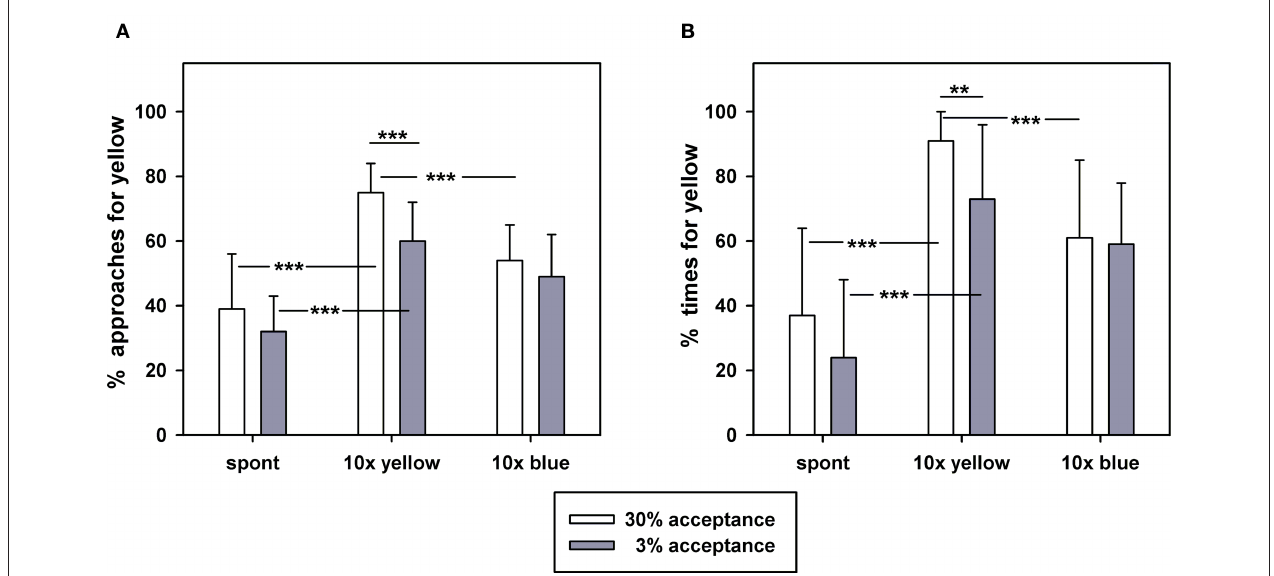
FiguRE 4 | Color learning at the hive entrance for two groups of bees which had acceptance thresholds ≤ 3% or ≥ 30% in the field. The abscissa of both graphs show choice behavior before learning (spont), after 10 learning trials with a yellow plate marking the hive entrance (10 × yellow), and after 10 reversal learning trials with a blue plate marking the hive entrance (10 × blue). (A) The ordinate shows mean percentages of approaches and the respective standard deviations toward the yellow plate compared with the approaches toward a blue